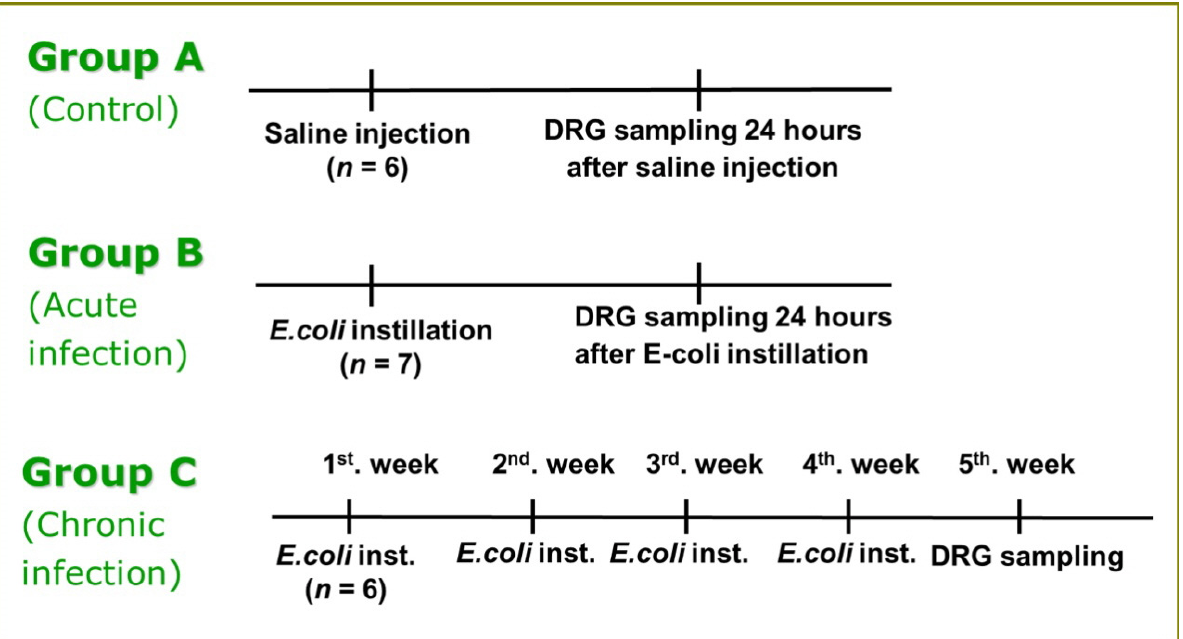
Figure 1. Study design of E.coli instillation and DRG sampling by group. A total of 19 adult female Sprague–Dawley rats were induced with acute E. coli infection (group B), chronic E. coli infection (group C), or served as controls (group A). In each group, the profiles of phosphorylated CREB cell were counted in 6–10 sections of each of the DRG collected. * DRG = dorsal root ganglia.